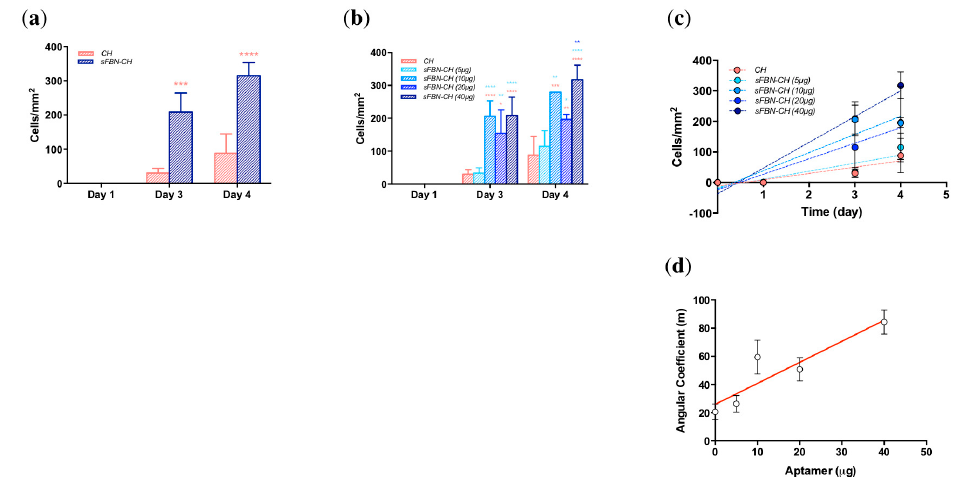
Figure 3. HeLa cells spreading on sFBN-CH. ( a ) Histograms showing the number of spread cells on CH and sFBN-CH after 1, 3 and 4 days of culture. ( b ) Histograms the number of spread cells on CH and sFBN-CH enriched with increasing doses of aptamers after 1, 3 and 4 days of culture. ( c ) The trend of cell spread rate on chitosan discs implemented with increasing aptamer doses. ( d ) The trend of angular coefficients derived from cell spread on chitosan discs implemented with increasing aptamer doses (* = p < 0.05).